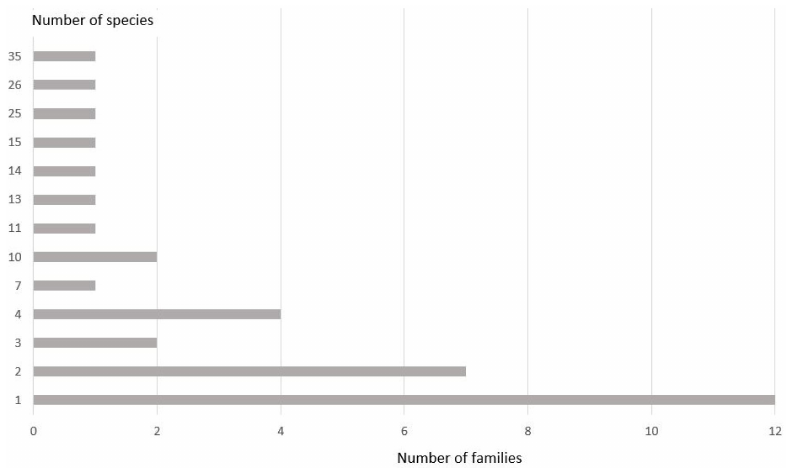
Figure 2. Distribution of Coleoptera families by the number of captured species in the beer traps. Table 2. Summary data from studies in